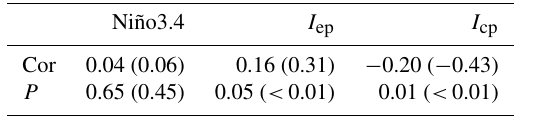
Table 2. Correlation coefficients between the time series of site- averaged winter haze days in China’s JJJ region and different types of El Niño indices. The values in parentheses indicate the correla- tion coefficients and confidence levels when only considering the stations where the correlations pass a 90% significance